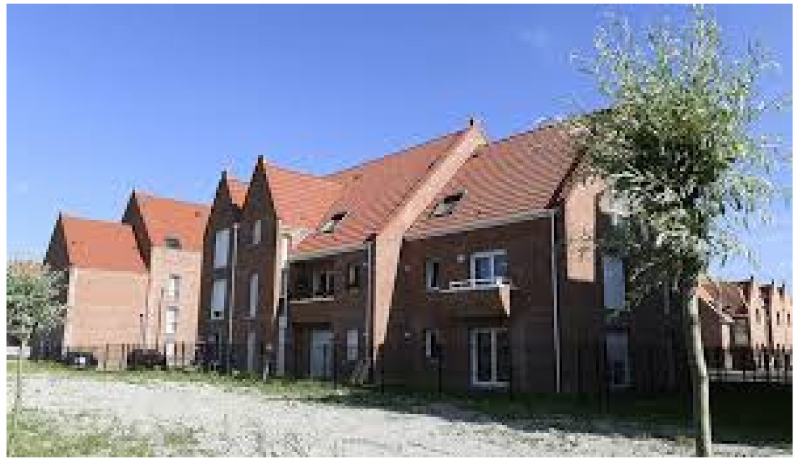
Figure 2. Natural gas network in district “petit village” at Capelle la Grande (France) with injection of hydrogen since June 2018 (https://grhyd.fr), accessed on 5 April 2018. The mixture of hydrogen and natural gas, in varying proportions of hydrogen not of about 100